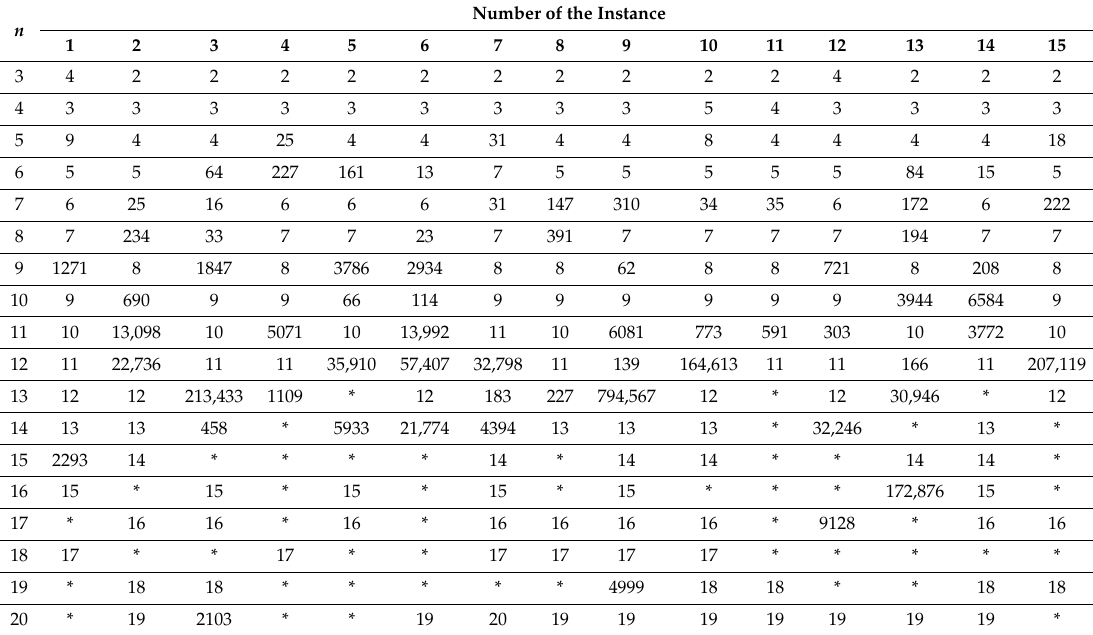
Table 1. Number of branching points in Algorithm 2 for the test instances generated according to [29]. Number of the